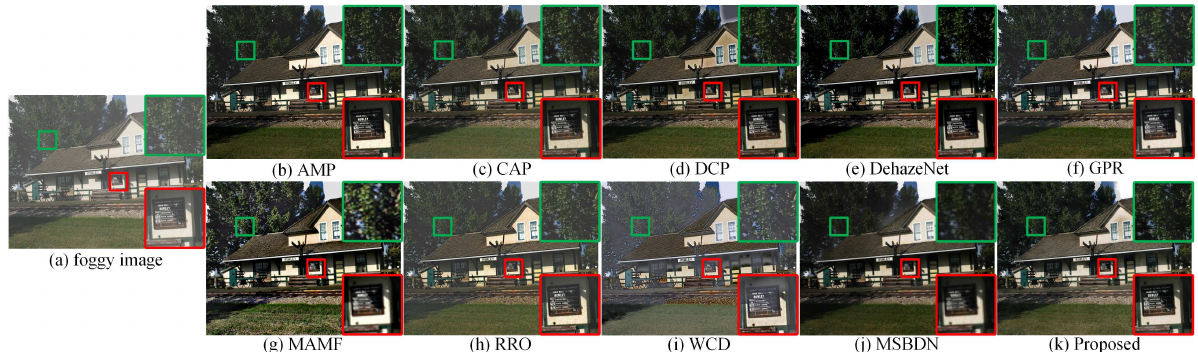
Figure 10. ( a ) shows a synthetic foggy image from HazeRD dataset. ( b – k ) respectively represent the defogged images obtained by AMP, CAP, DCP, DehazeNet, GPR, MAMF, RRO, WCD, MSBDN, and the proposed method. The two partially enlarged images marked in the green and red frames correspond to two areas enclosed by the green and red frames in each defogged